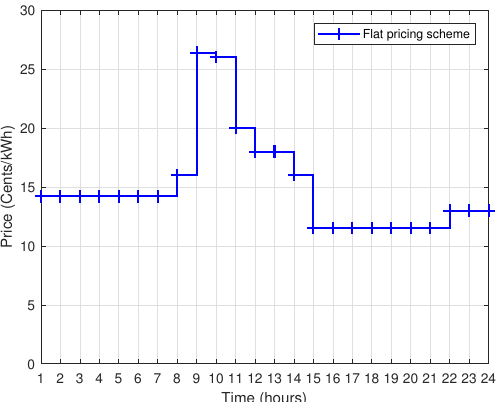
Figure 5. Utility advertised flat pricing scheme.